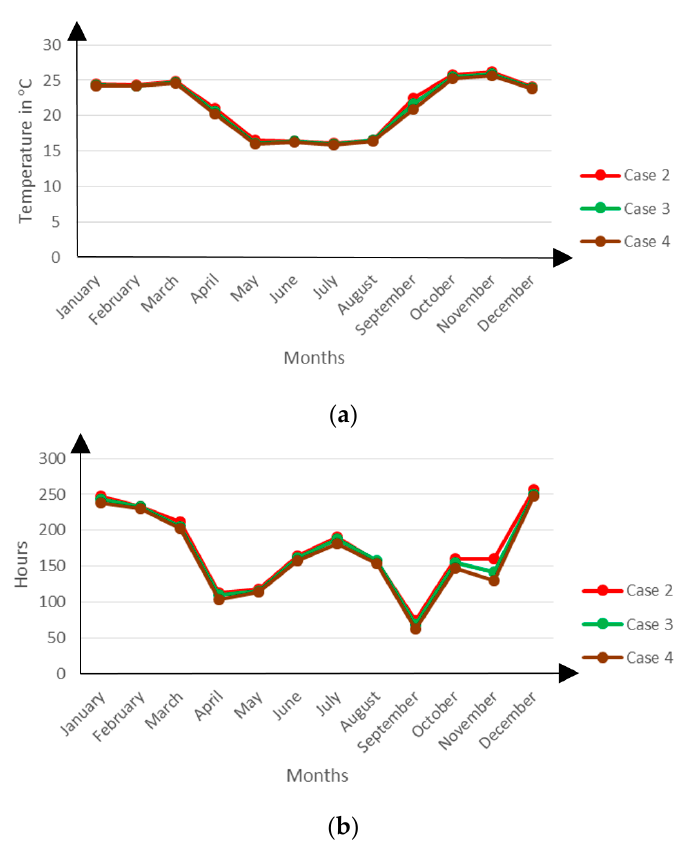
Figure 8. Monthly mean zonal temperature ( a ) and discomfort hours ( b ) for Cases 2, 3 and 4.